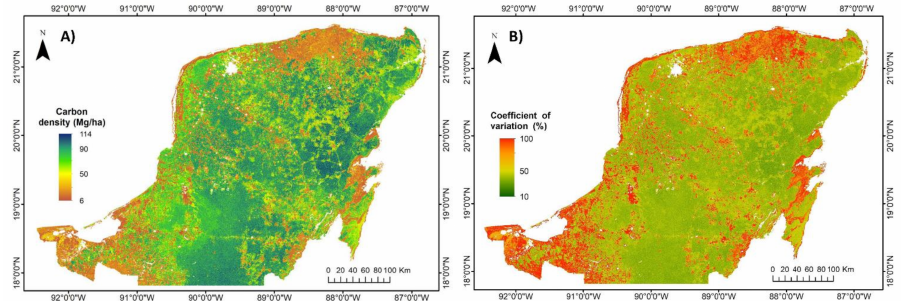
Figure 3. Estimated map of the aboveground carbon density for the entire Yucatan Peninsula ( A ) and the uncertainty map, measured with coefficient of variation ( B ).